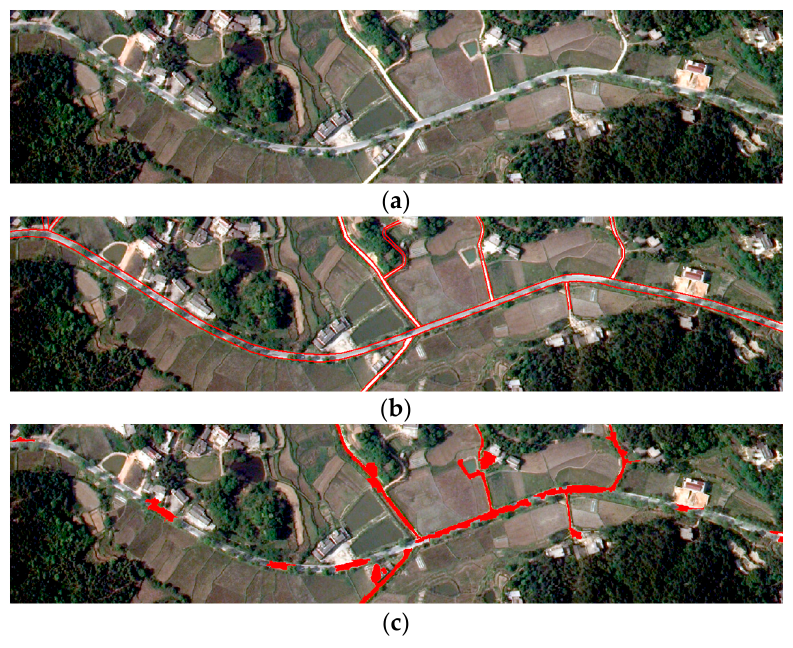
Figure 18. Comparison of GFI and OOC result in region 1: ( a ) remote sensing image, ( b ) GFI result, ( c ) OOC result.